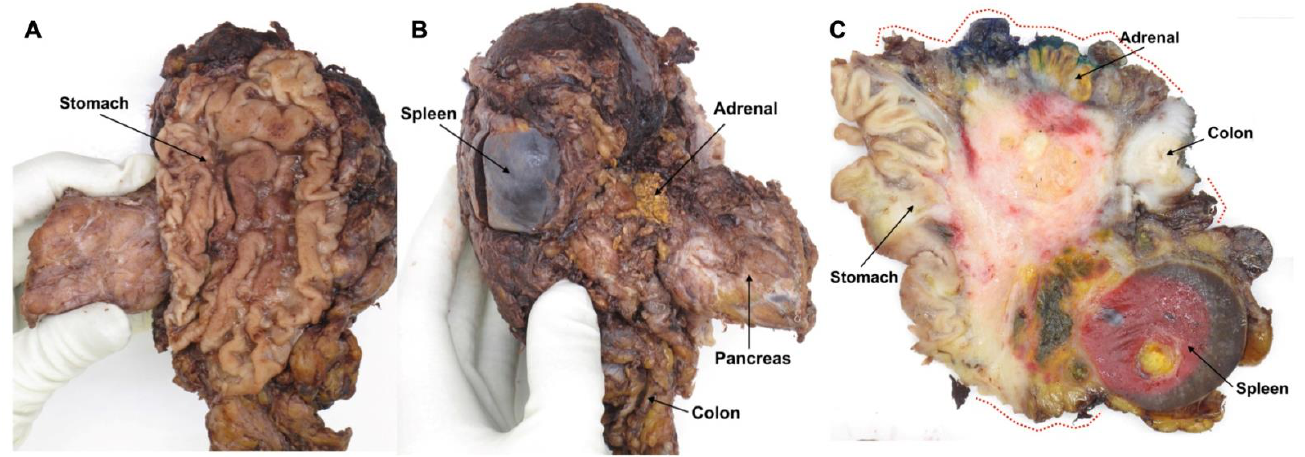
Figure 1. Resection margins in an extended distal pancreatectomy specimen that includes a part of the stomach ( A ) and the left adrenal gland and a segment from the left colonic flexure ( B ). Sagittal slicing reveals a large pancreatic cancer that invades all three additionally resected organs and grows close to the circumferential margin of the soft tissue between these structures ( red dotted lines ) ( C